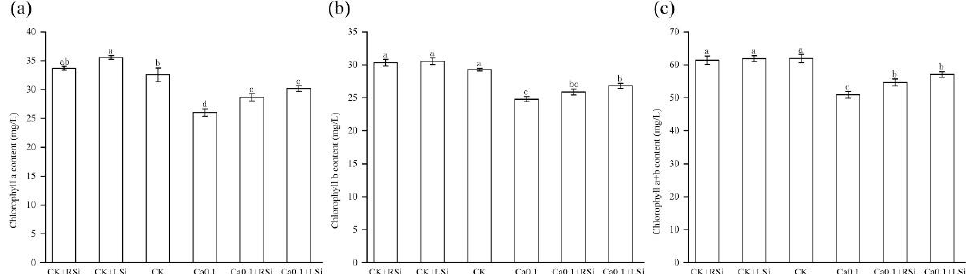
Figure 3. Effect of exogenous Si on chlorophyll content of tomato leaves under low − calcium stress. ( a ) Chlorophyll a content; ( b ) chlorophyll b content; ( c ) chlorophyll a + b content. The means of three replicates ± standard error is shown. The data were subjected to an ANOVA test to determine the LSD and bars superscribed by different letters are significantly different at p < 0.05. Standard errors are indicated by bars. CK + RSi: 4 mM Ca in Hoagland nutrient solution + root application of 1 mM Si; CK + Lsi: 4 mM Ca in Hoagland nutrient solution + foliar application of 1 mM Si; CK: 4 mM Ca in Hoagland nutrient solution; 0.1Ca: 0.1 mM Ca in Hoagland nutrient solution; 0.1Ca + Rsi: 0.1 mM Ca in Hoagland nutrient solution + root application of 1 mM Si; 0.1Ca + Lsi: 0.1 mM Ca in Hoagland nutrient solution + foliar application of 1 mM Si.